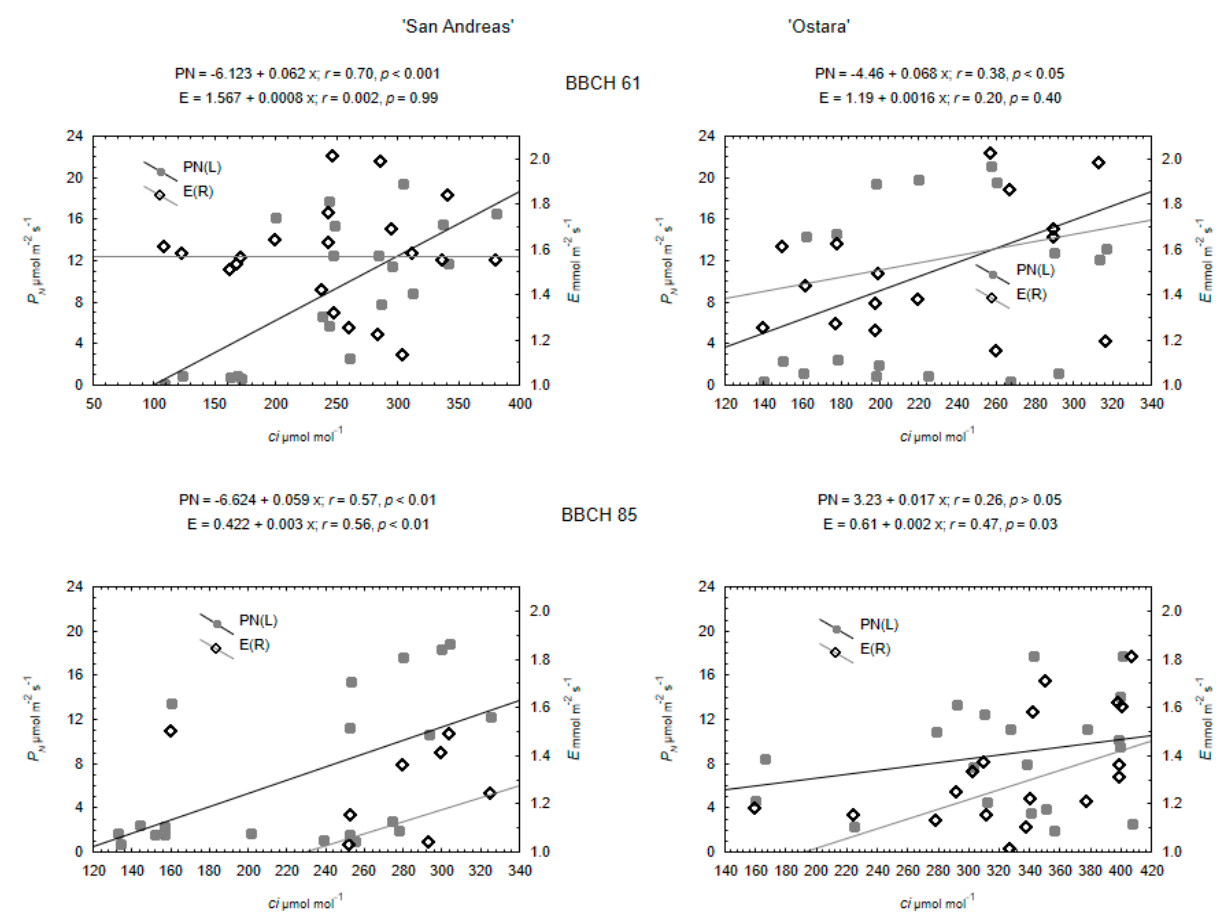
Figure 3. The relationships are based on r -Pearson’s correlation coefficient and linear regressions between the concentration of intercellular CO 2 ( Ci ) vs. photosynthetic rate ( P N ) and transpiration ( E ) parameters at two growing stages of strawberry. Table 4. Gas-exchange parameters at two growing stages (1—BBCH 61, 2—BBCH 85) of two wild strawberry cultivars. Cultivar Stage